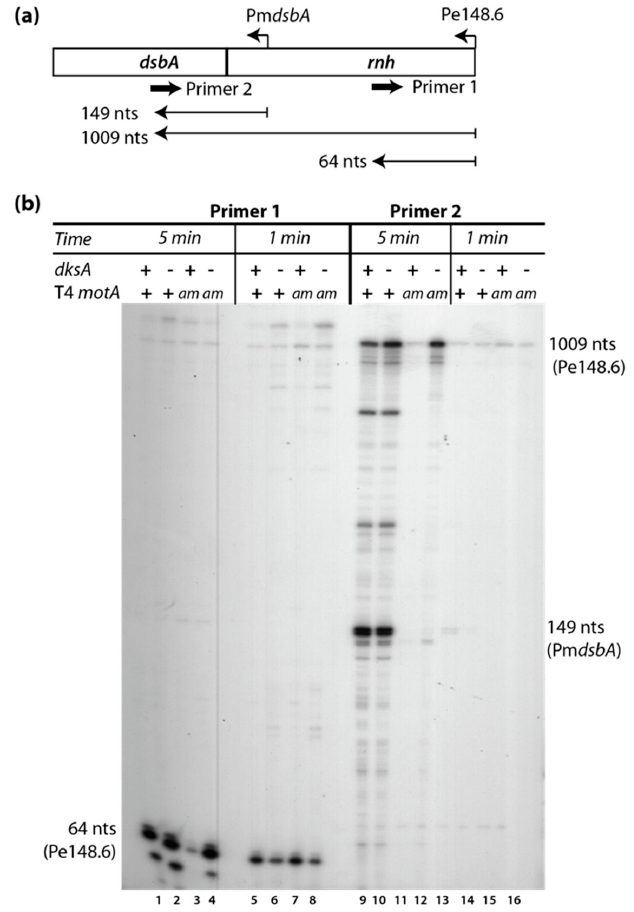
Figure 4. RNA from Pe148.6, which is significantly reduced in a T4 motA am infection of B606 wt at 5 min post-infection, is rescued by a deletion of DksA. ( a ) Schematic showing T4 map units from 150,727 to 149,509 containing genes rnh and dsbA with the relative positions of the early promoter Pe148.6 and the middle promoter Pm dsbA and the primers used for primer extension analyses. Sizes of the expected primer extension products are indicated in nts; ( b ) Representative gel showing the primer extension products from primers indicated in panel (a). RNA was isolated from T4 wt (+) or T4 motA am ( am ) infections of strain B606 wt (+) or B606 Δ dksA ( − ) at 5 or 1 min post-infection.